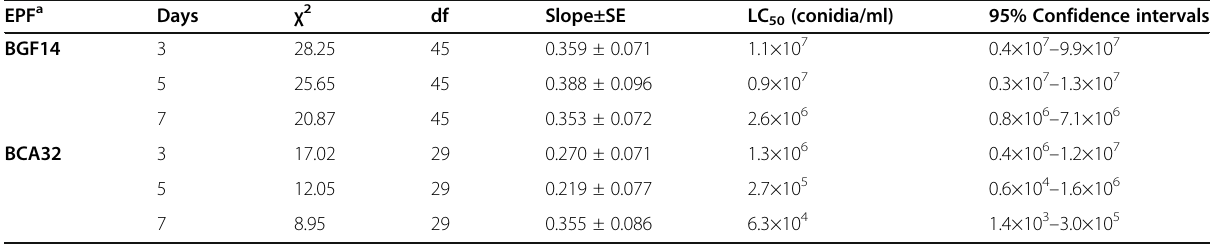
Table 2 Median lethal concentration (LC 50 ) of Beauveria bassiana (BGF14 and BCA32 isolates) against Tetranychus urticae adults EPF a Days χ 2 df